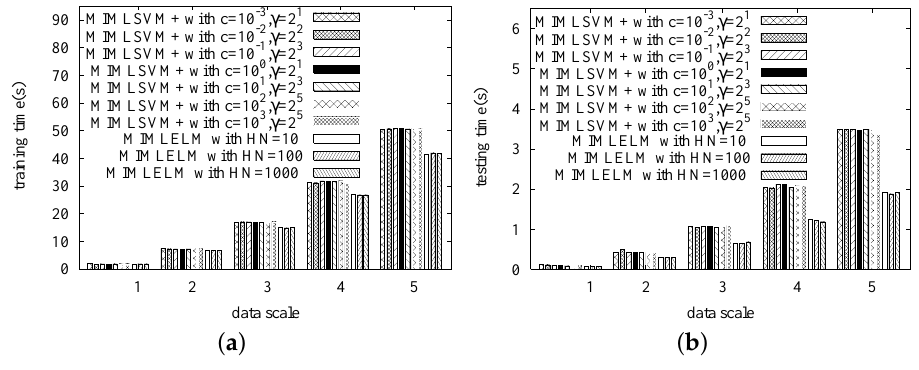
Figure 8. The efficiency comparison on the Azotobacter vinelandii dataset. ( a ) The comparison of the training time; ( b ) the comparison of the testing